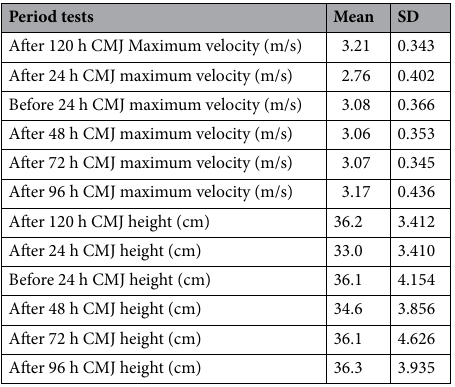
Table 1. Descriptive statistics.